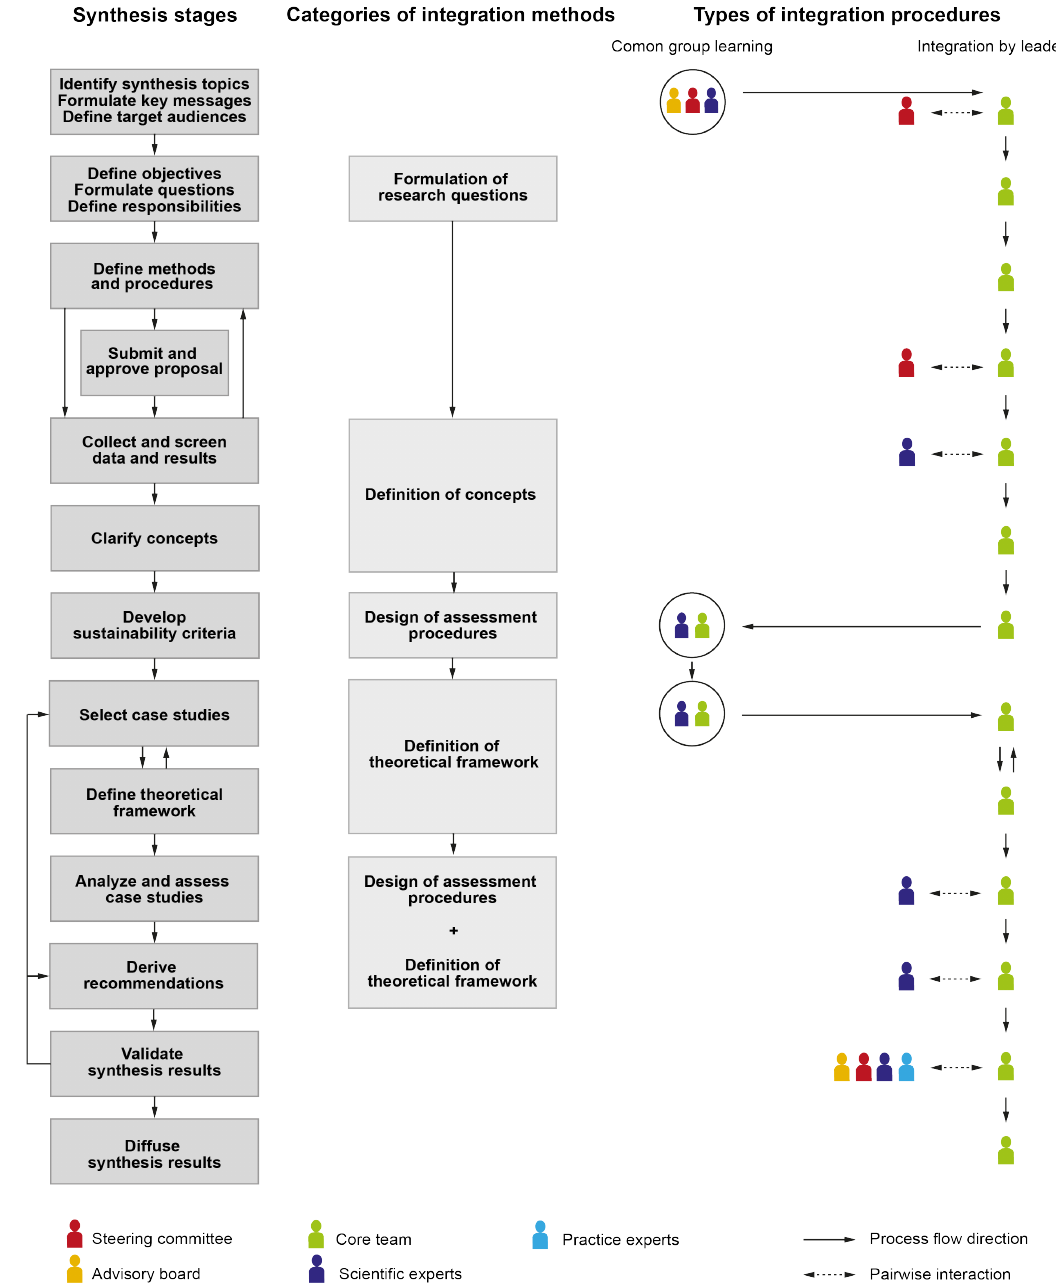
Fig. A3.3: Overall integration strategy of thematic synthesis 4 differentiated by synthesis stages, categories of integration methods, and types of integration procedures. The composition of the steering committee and the advisory board are described in the main text. The core team involved researchers and consultants from geography and economy (n=2); scientific experts represented geography, biology, agroecology, decision analysis, law and political science (n=8); practice experts represented the federal office for the environment and consulting companies